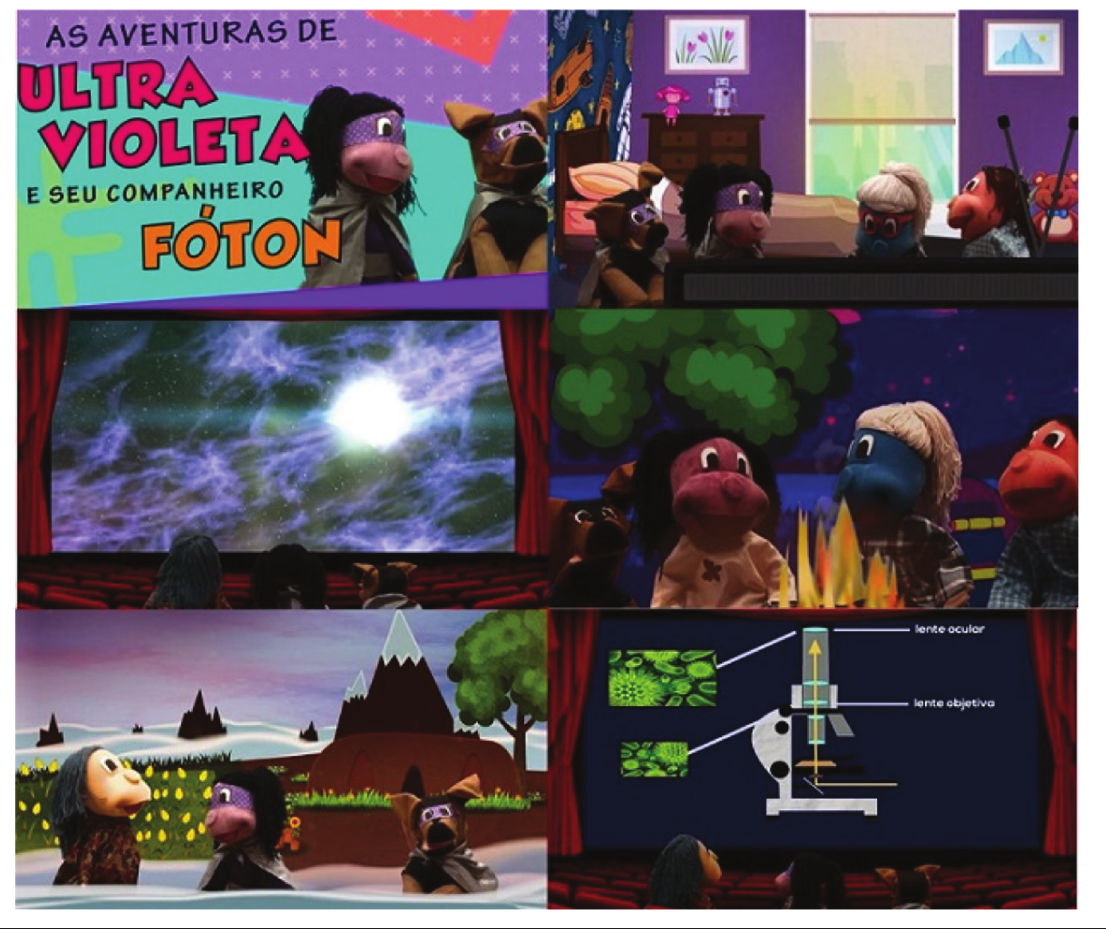
Figure 5. Characters from the series ‘The adventures of Ultraviolet and her companion